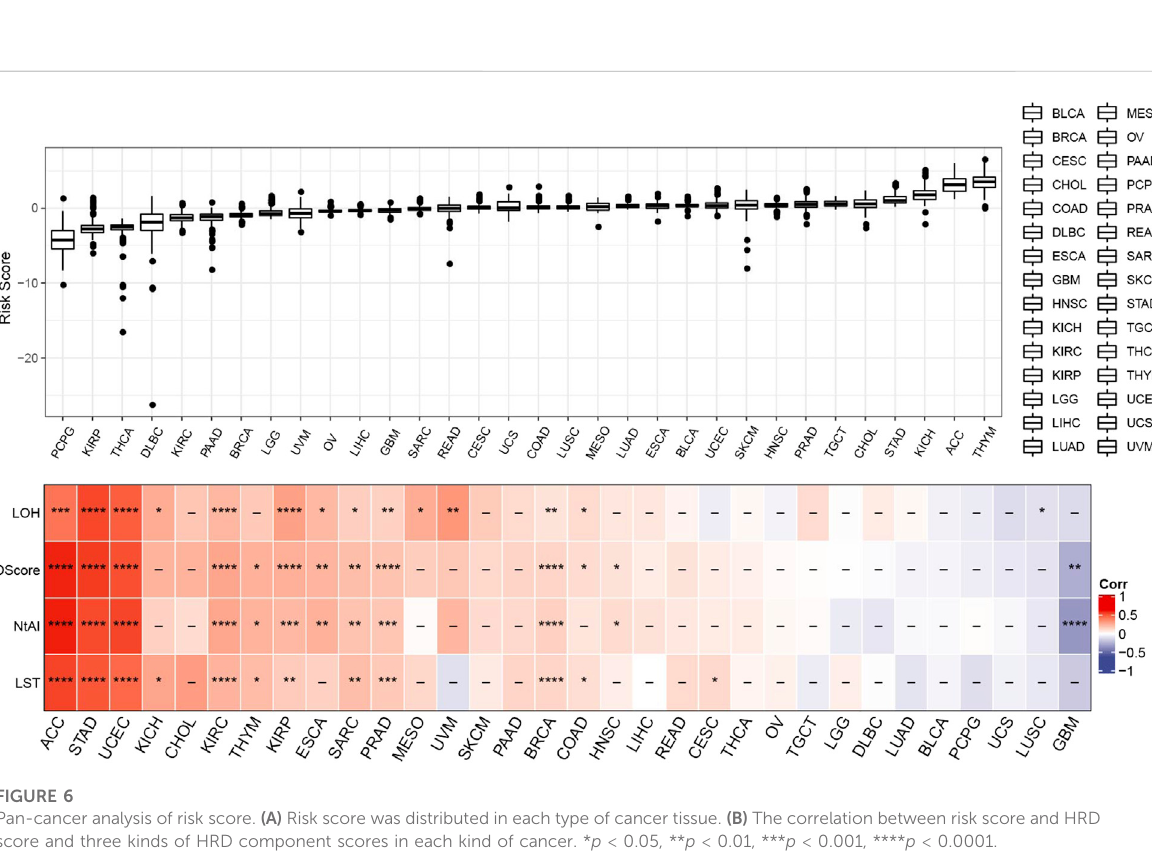
FIGURE 6 Pan-cancer analysis of risk score. (A) Risk score was distributed in each type of cancer tissue. (B) The correlation between risk score and HRD score and three kinds of HRD component scores in each kind of cancer. * p < 0.05, ** p < 0.01, *** p < 0.001, **** p <